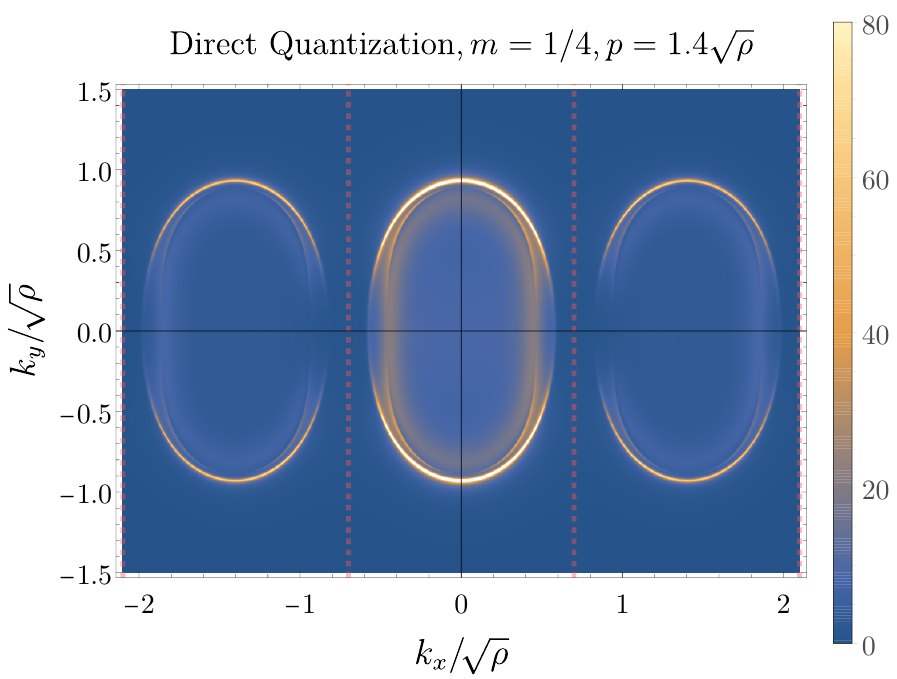
Figure 7 . The destruction of the Fermi surface in strong unidirectional holographic lattice potentials ( (cid:21) = 8 : 0 ) . Zooming on the picture shown on the bottom left in (cid:12)gure 6, it is clearly seen that the Fermi surface loses its sharpness and even disappears around k y =